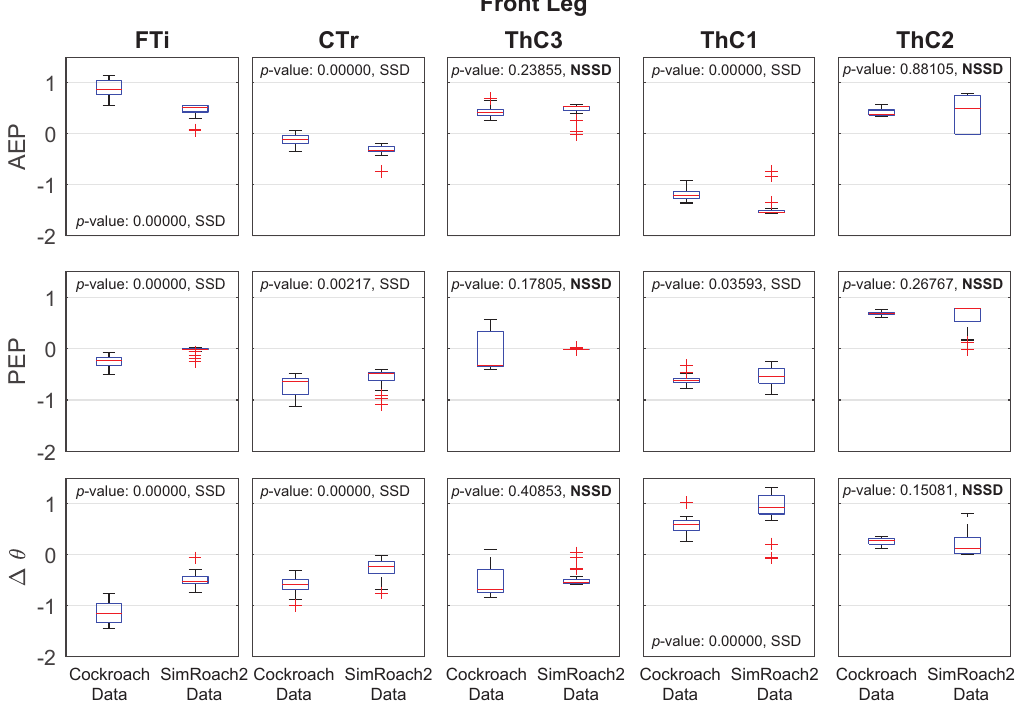
Figure 12. Front leg anterior extreme position (AEP), posterior extreme position (PEP), and ∆ θ joint angle data in a cockroach and in SimRoach2. Thirty six cockroach data points were used. Thirty three SimRoach2 data points were used. p -values from the two-sample t -tests and whether there is a statistically-significant difference (SSD, bad match) or no statistically-significant difference (NSSD, good match) between the samples are